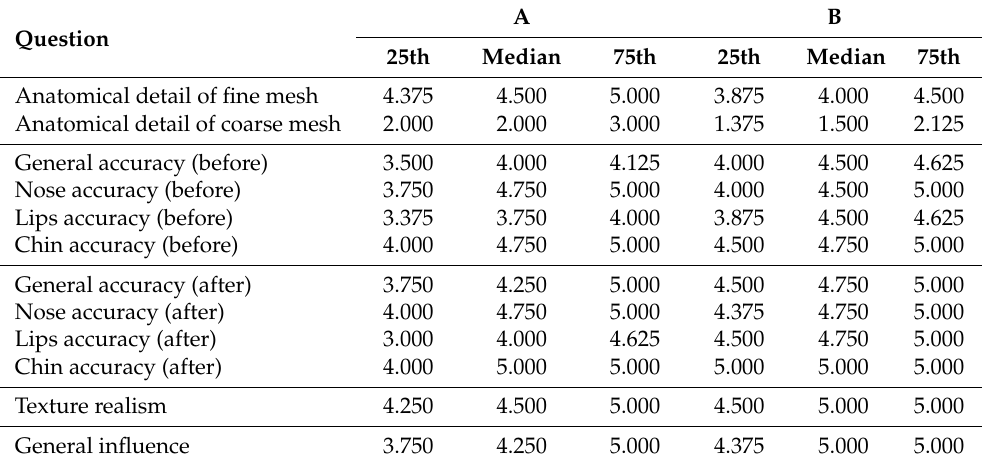
Table 4. First quartile, median and third quartile of the answers to the evaluation questions for both surgeons (A and